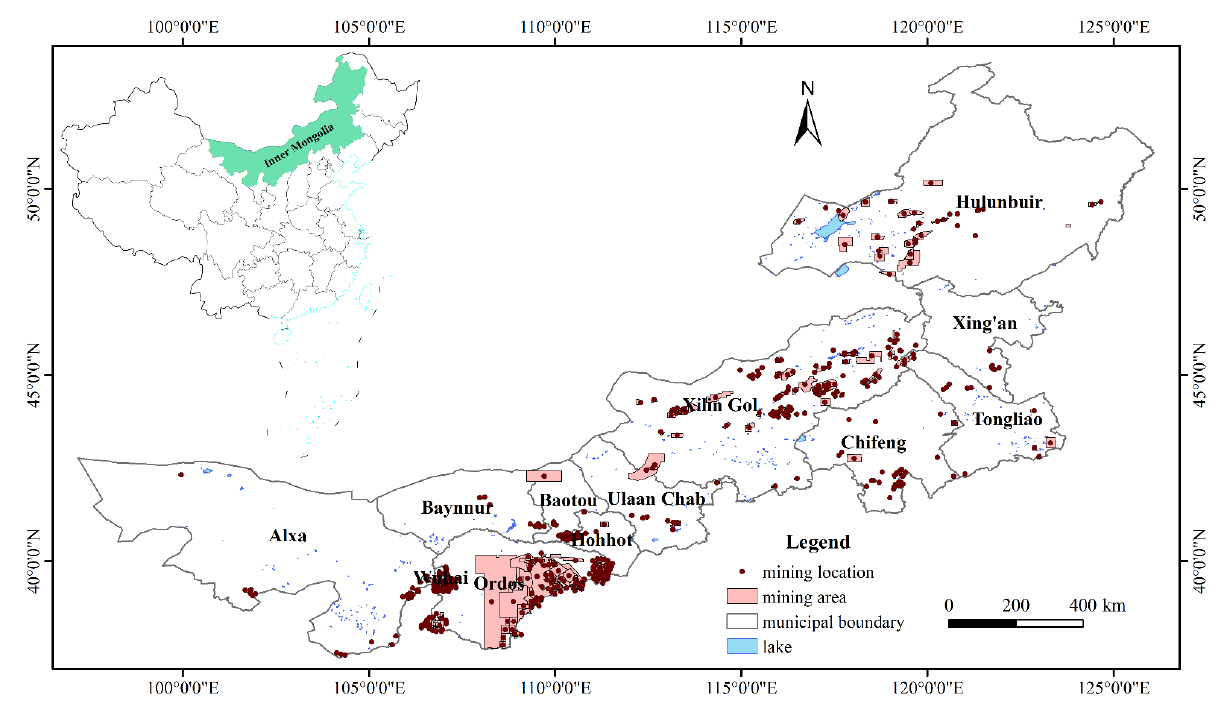
Figure 7. Distribution of lakes, mining sites, and planned mining zones throughout Inner Mongolia. Table 7. Number of lakes within 10 km and 5 km of mining sites within the different geomorphological units.